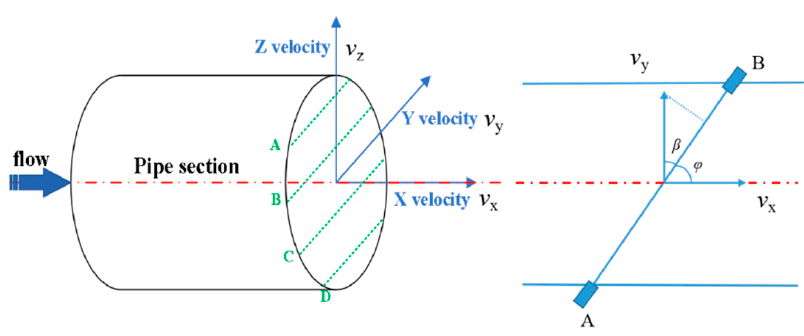
Figure 13. The orientation of the velocity components in the pipe.